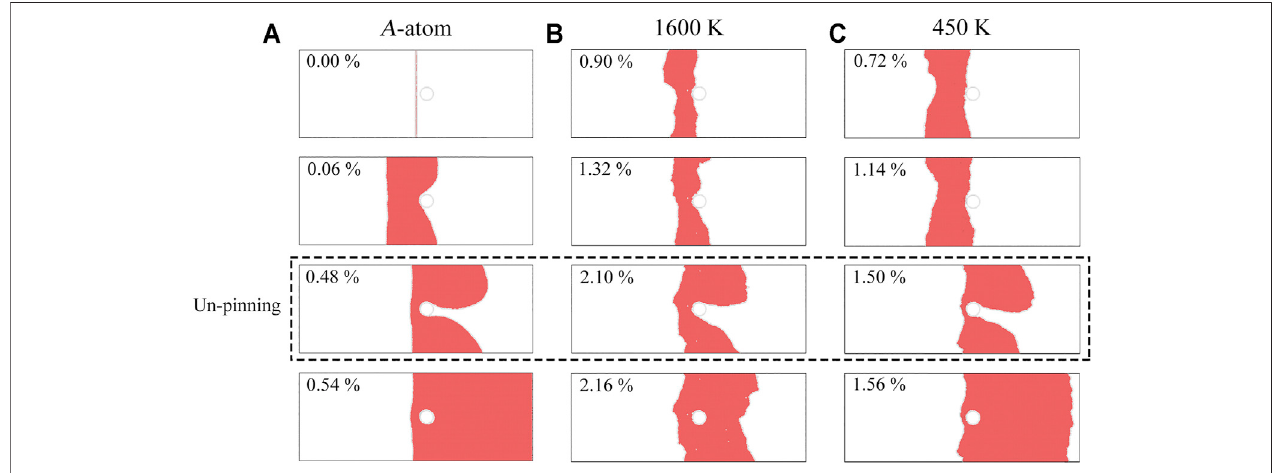
FIGURE 7 | Snapshots at various applied shear strains for the con fi guration and the movement of the edge dislocation in (A) the sample with nanoprecipitates simulated by the A-atom potential; (B) the sample with nanoprecipitates annealed at 1600 K; (C) the sample with nanoprecipitates annealed at 450 K.